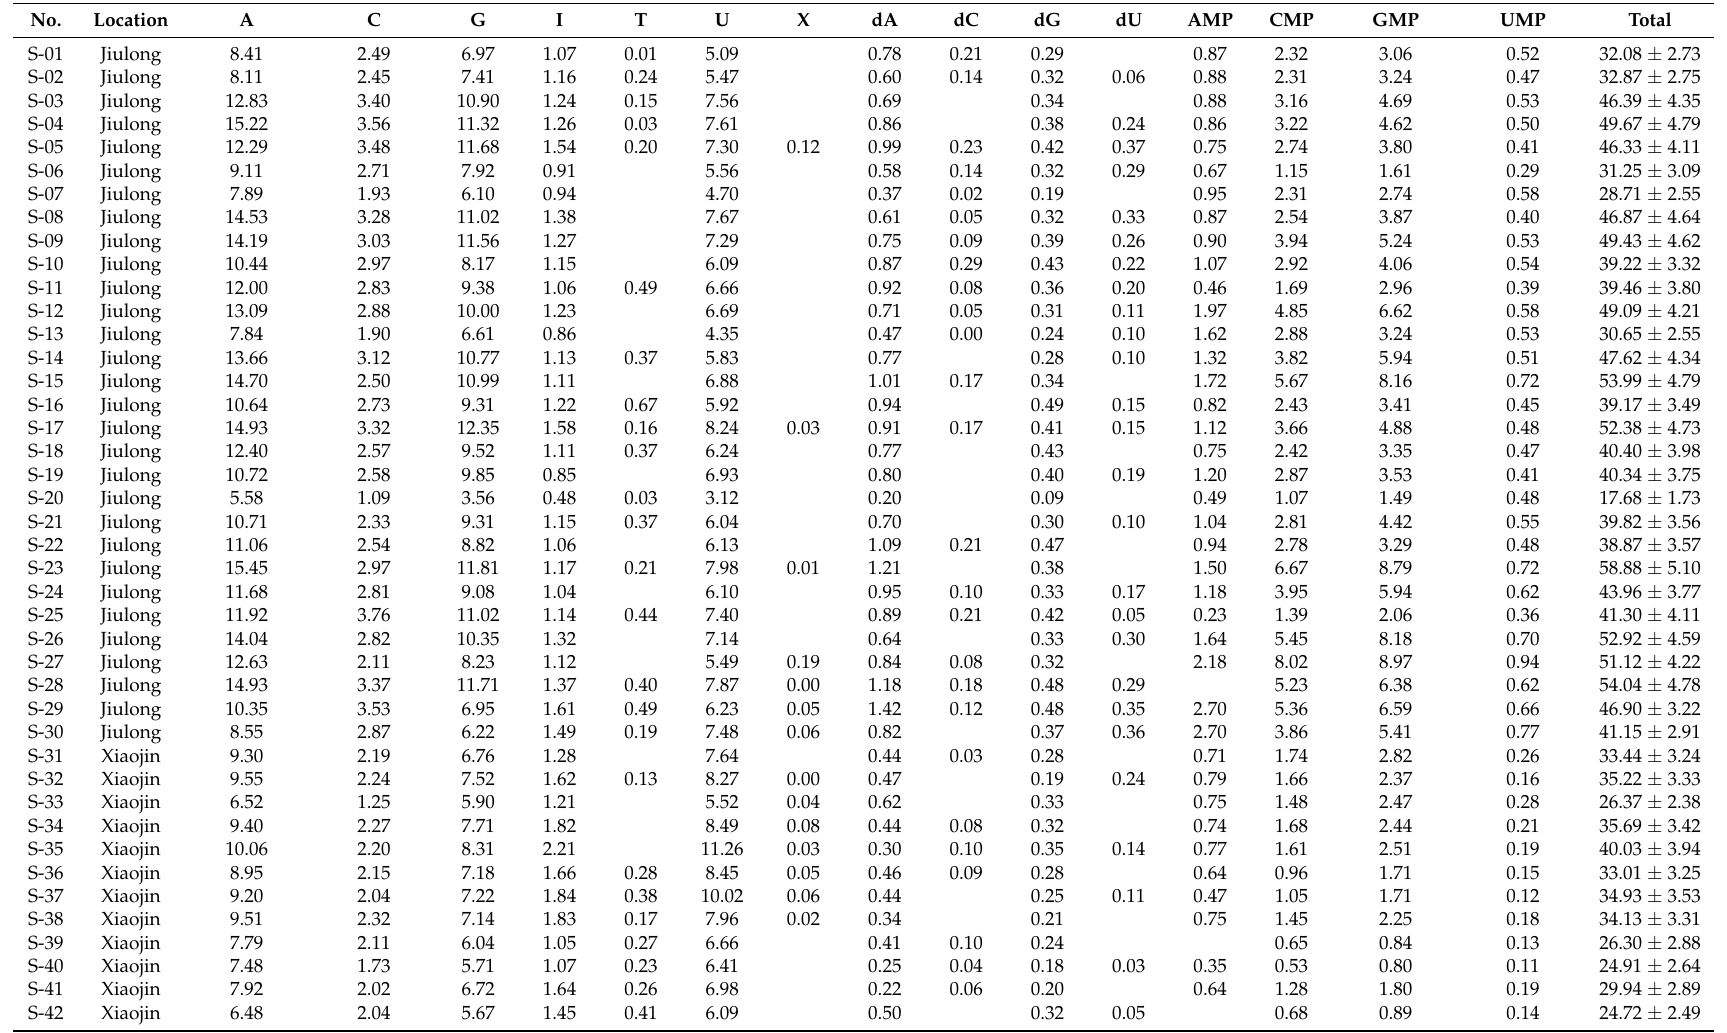
Table 3. The contents of 15 nucleic acid constituents in 80 T. matsutake samples (mg/100